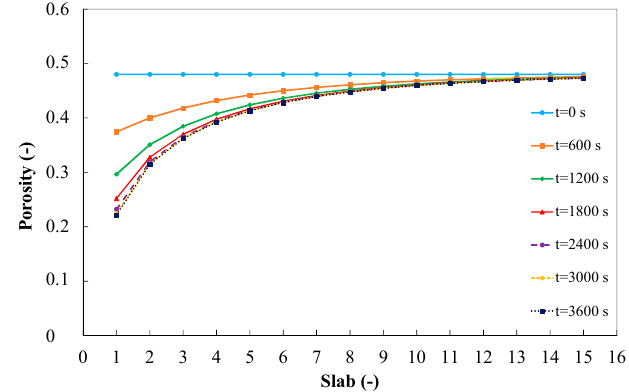
Figure 9. Evolution with the time of porosity in each slab of the porous medium.